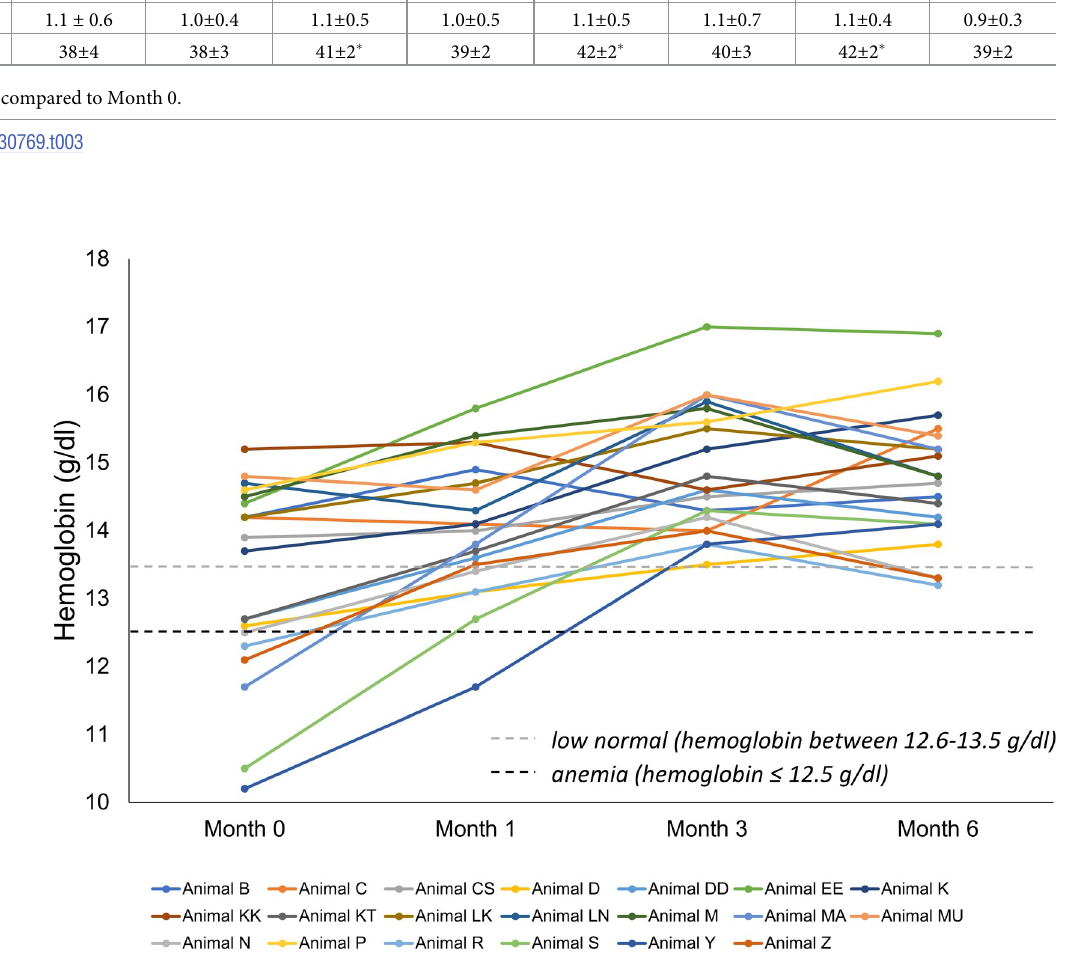
Fig 1. Alleviated anemia (anemia defined as hemoglobin � 12.1 g/dl) and raised low-normal hemoglobin (low-normal hemoglobin defined as 12.2–13.2 g/dl) in bottlenose dolphins ( Tursiops truncatus ) within three months on a modified fish